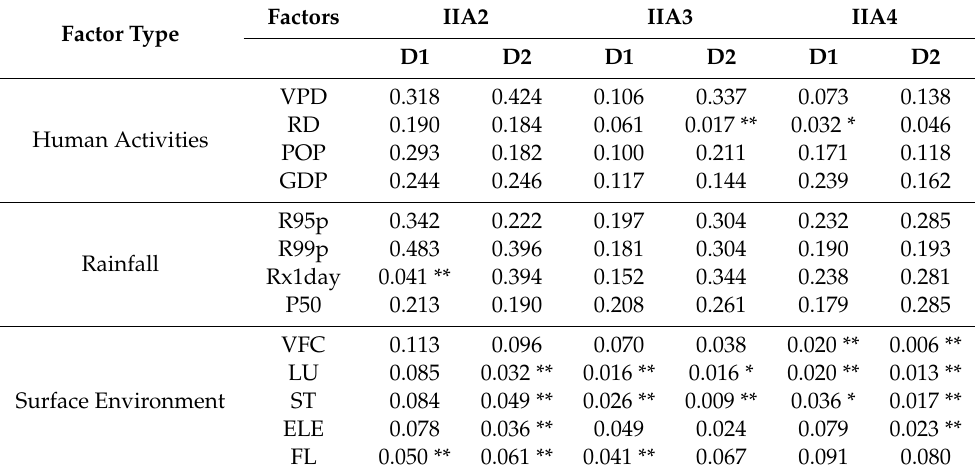
Table 5. Results of the factor detection in Fujian from D1 to D2. Factor